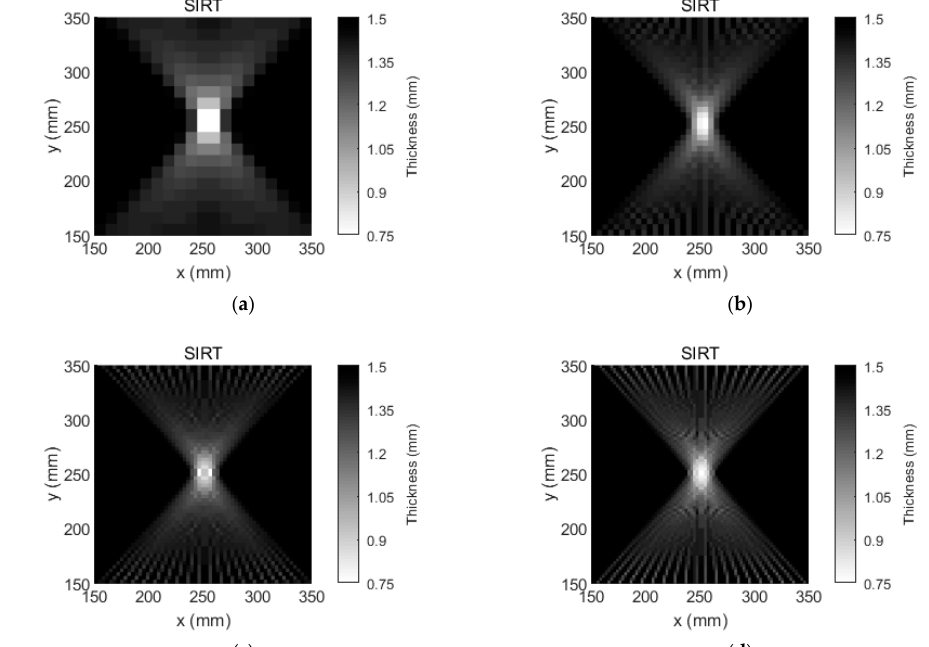
Figure 6. Tomographic reconstruction images for a 1.5 mm thick aluminum plate with a 20 mm diameter circular flat-bottomed hole with different grid density using the SIRT. The thickness loss was 50% within the flaw. ( a ) The number of grids was 20 × 20, ( b ) the number of grids was 40 × 40, ( c ) the number of grids was 60 × 60, and ( d ) the number of grids was 80 × 80.